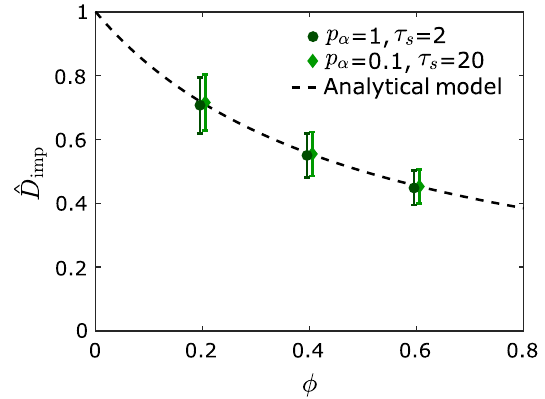
FIG. 8. Relative effective diffusion coefficient obtained from Monte Carlo simulations of pointlike phage diffusing through a field of penetrable sticky obstacles. These obstacles result in a reduction in the effective diffusion coefficient of the phage in agreement with the mean-field analytical model of implicit density dependence Eq. (22) (see Sec. VI). Simulation data offset slightly for clarity.